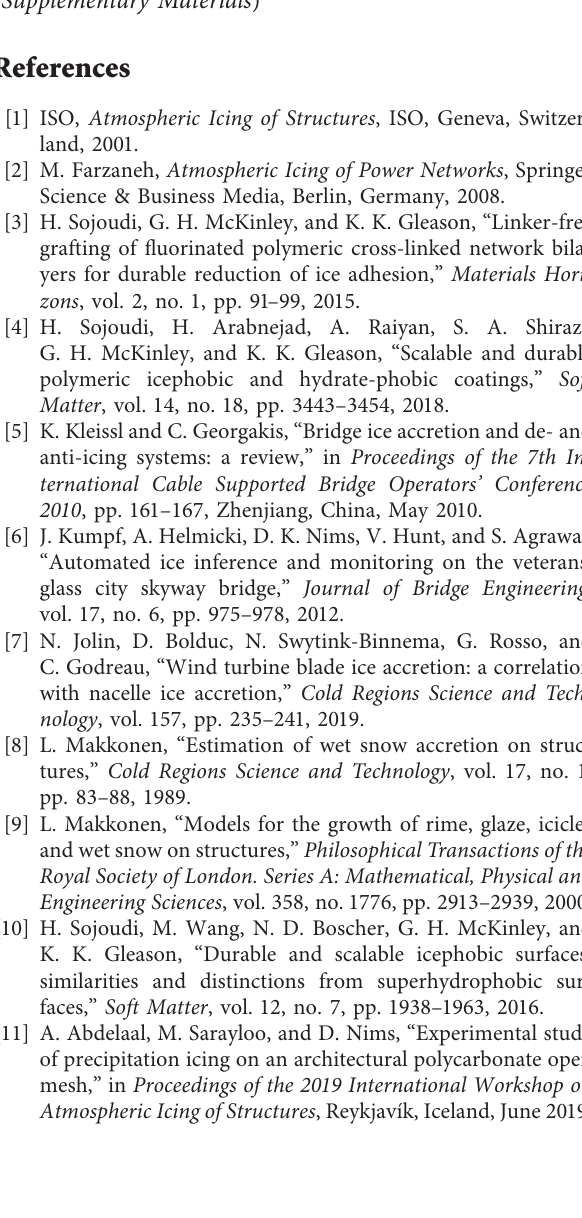
Figure S1: a comparison of the shape and the thickness of accumulated snow on cable stays with simulation results for two different events. Table S1: summary of the general governing equation of the realizable κ - ε turbulence model in order to solve the continuity and Navier–Stokes equations. Video S1: real-time snow accumulation on cable stays. ( Supplementary Materials )